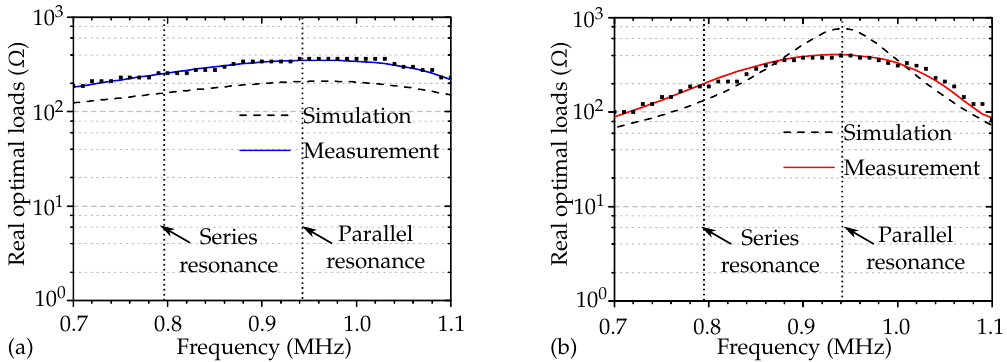
Figure 7. Simulated and measured real optimal electric loads at the receiver to maximize power transfer for each analyzed driving frequency with ( a ) aluminium as the transmitting medium and ( b ) POM as the transmitting medium. The squares show the measured data points, and the solid line is obtained by filtering discrete data points.